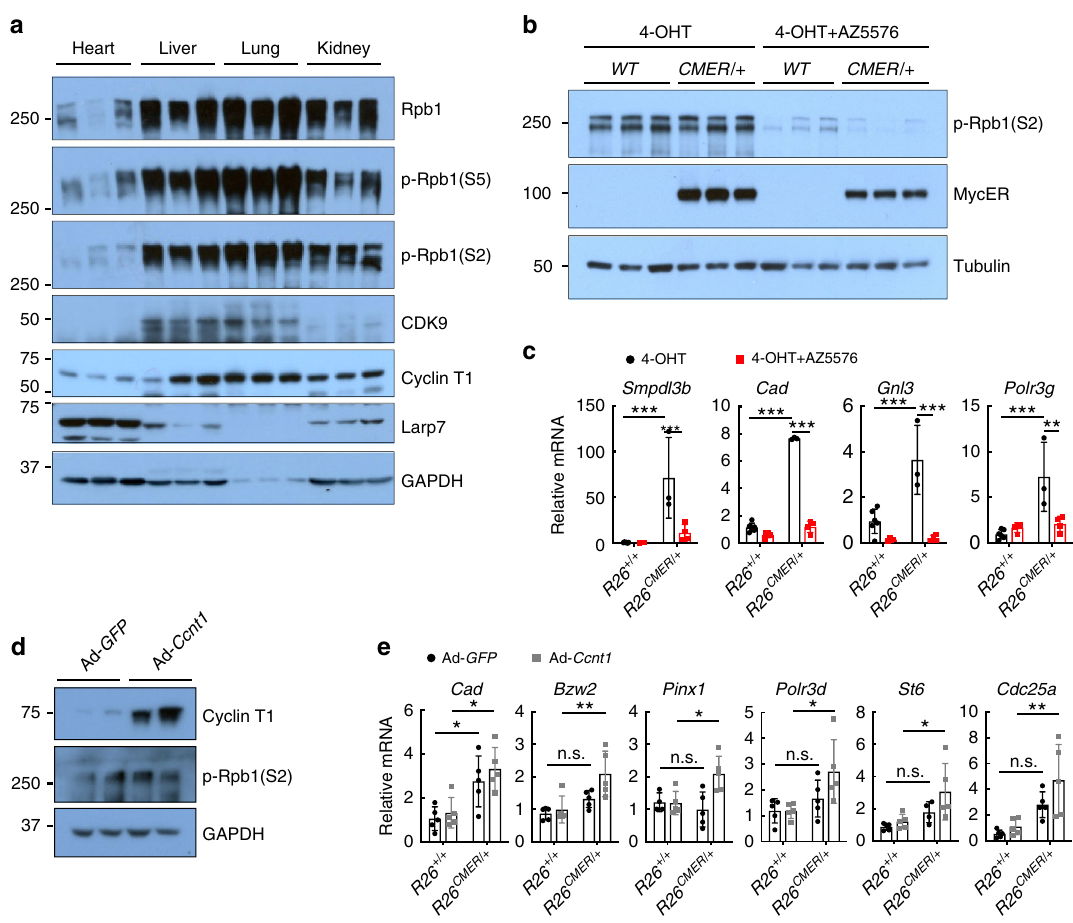
Fig. 5 Inhibition or overexpression of P-TEFb modulates ef fi ciency of Myc-driven transcription. a Immunoblot analysis of the C-terminal domain (CTD) of RNA Polymerase II — total (Rpb1) and phosphorylated (p-Rpb1(S5) and p-Rpb1(S2)), CDK9, Cyclin T1 and Larp7 expression in the heart, liver, lung and kidney isolated from wild-type ( R26 + / + ) mice. The composite fi gure is generated from the same samples loaded across multiple blots and a representative image for GAPDH is shown. b Immunoblot analysis of the CTD of RNA Polymerase II, phosphorylated (p-Rpb1(S2)), and MycER T2 protein expression in wild type (R26 + / + ) or R26 CMER/ + livers, isolated 4 h post administration of 4-OHT either alone (4-OHT) or in combination with 60 mg/kg AZ5576 (4-OHT + AZ5576). c Quantitative RT-PCR analysis of Smpdl3b , Cad , Gnl3 and Polr3g in wild type ( R26 + / + ) and R26 CMER/ + livers, isolated 4 h post administration of 4-OHT ( n = 6 R26 + / + , n = 3 R26 CMER/ + ) either alone or in combination with 60 mg/kg AZ5576 (4-OHT + AZ5576, n = 4). Expression is relative to the respective wild type ( R26 + / + ). Mean and s.d shown. Two-way ANOVA with Tukey ’ s multiple comparisons test; R26 + / + vs 4-OHT: *** P = 0.001 ( Smpdl3b, Cad, Gnl3 and Polr3g ), R26 CMER/ + 4-OHT vs 4-OHT + AZ5576: *** P = 0.001 ( Smpdl3b , Cad and Gnl3 ), ** P ≤ 0.01 ( Polr3g ). d Immunoblot analysis of Cyclin T1 and phosphorylated CTD of RNA polymerase II (p-Rpb1(S2)) in R26 CMER/ + primary cardiomyocytes infected with an adenovirus encoding either GFP ( Ad-GFP ) or Ccnt1 ( Ad-Ccnt1 ). Replicate samples are derived from independent primary cardiomyocyte isolations. e Quantitative RT- PCR analysis of Cad , Bzw2 , Pinx1, Polr3d, St6 and Cdc25a in wild type ( R26 + / + , n = 5 except Pinx1 where n = 4 for Ad-GFP control) and R26 CMER/ + ( n =